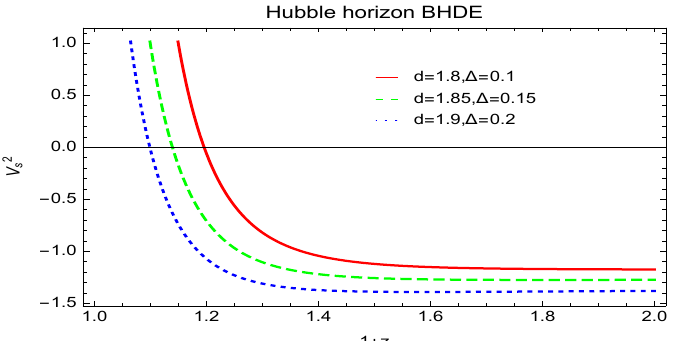
Figure 7. Plot of squared speed of sound V 2 s versus redshift parameter 1 + z for BHDE model with Hubble horizon for for GDP braneworld cosmology.